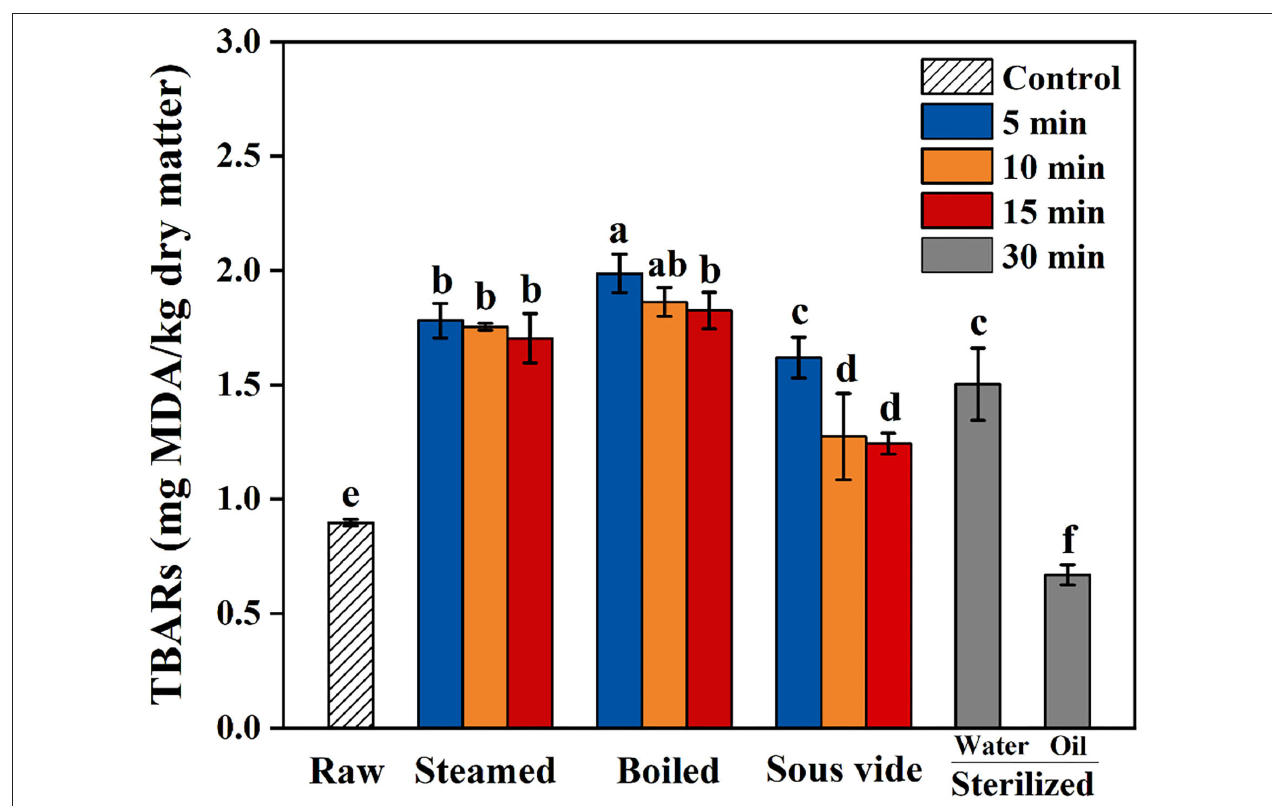
FIGURE 2 | Effect of steamed, boiled, sous vide, and sterilized treatments on the levels of (A) glyoxal (GO) and (B) methylglyoxal (MGO) in raw and processed oysters. Error bars indicate standard deviation ( n = 3). Samples designated with different lowercase letters were significantly different ( p < 0.05).